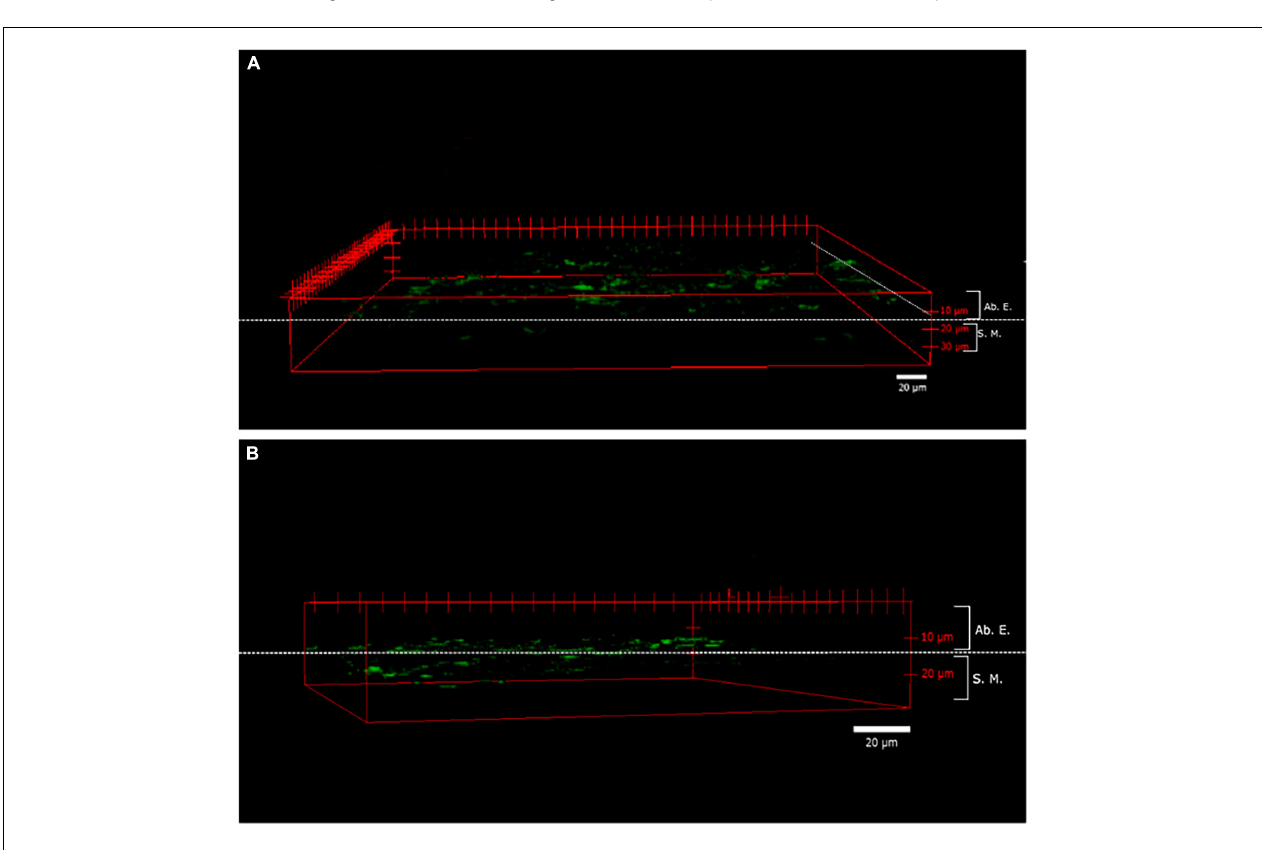
FIGURE 2 | Penetrability of fluorescein disodium salt (FNA) in whole almond leaves. A three-dimensional (3D) reconstruction of the images obtained through a confocal laser scanning microscope (CLSM) of almond leaves from the abaxial epidermis to adaxial epidermis, 2 h after FNA- encapsulated foliar application: superficial expansion view (A) and the depth of nanovesicles view (B) . Ab. E., abaxial epidermis; S.M., spongy